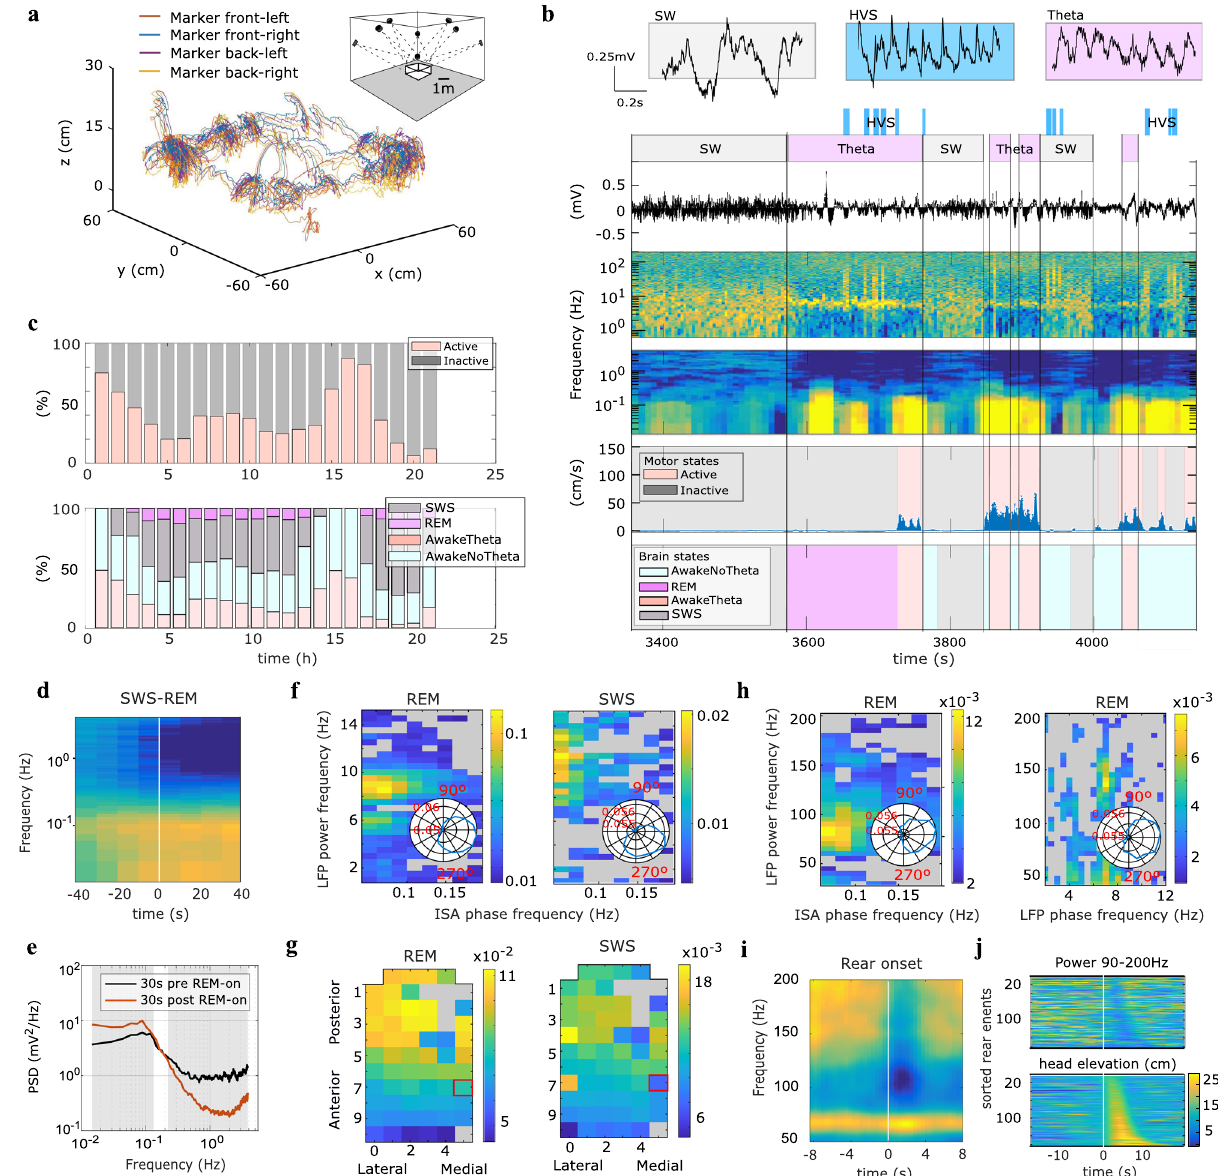
Fig. 5 Infra-slow to high-gamma correlates of sleep and behavioral states. a 3D trajectories of the head position of the rat. The inset shows a scheme of the position of the Mocap. b The spectrogram and raw LFP signal of an illustrative channel is displayed for distinct brain states (top); slow-wave (SW), high-voltage spindles (HVS) and Theta. Movement speed is displayed along with classi fi cation of motor state (middle) and brain states (bottom). c Top: percentage of time in the active vs. inactive state (interruptions to replace the battery not included). Bottom: percentage of time the rat was in each main brain state. d Average 0.015 – 4Hz spectrogram for one DC channel triggered on REM episode onsets ( n = 44). e Median PSD across SWS-REM transition episodes ( n = 44) for 30s periods pre and post REM onset. Shaded area marks frequency bins with signi fi cant difference ( p <0.05, permutation test). f Color-coded strength of modulation of LFP power across slow frequency range ( y -axis) for one channel by the phase of ISA across 0.05 – 0.2Hz range derived from one DC channel (see panel g ) during REM sleep (left) and SWS (right) states. Gray color indicates nonsigni fi cant modulation. Insets show circular plot of LFP power in theta/spindle band as a function of ISA phase. g Color-coded topographic maps of ISA phase modulation of LFP power in theta band during REM (left) and spindle band during SWS (right). ISA phase derived from DC channel marked with a red square. h Color-coded strength of modulation of LFP power across gamma frequency range ( y -axis) for one channel by the phase of ISA across 0.05 – 0.2Hz range derived from one DC channel (left) and by the phase of LFP in the slow frequency range rhythm (right) during REM. Inset, circular plot of LFP gamma power with respect to respective (ISA or theta) phase. i Average spectrogram for high- frequency range of LFP on posterior channel triggered on rear onset ( n = 162). j Head elevation (bottom) and high gamma power (top, same channel as in i ) color-coded and centered on rearing onset shown for all events sorted by duration of rear to SWS, and the ISA phase of maximal LFP power differed of LFP power across cortex, with both theta power during REM between states being close to the peak (~340°) in REM and and spindle power during SWS showing strongest modulation in ascending phase (~300°) in SWS. Taking advantage of the posterior part of the array (Fig. 5g). While theta oscillations coverage of a signi fi cant section of dorsal cortical mantle by our measured on the cortical surface are generated by volume array, we assessed the spatial extent of the ISA phase modulation conduction of multiple theta-rhythmic current generators of